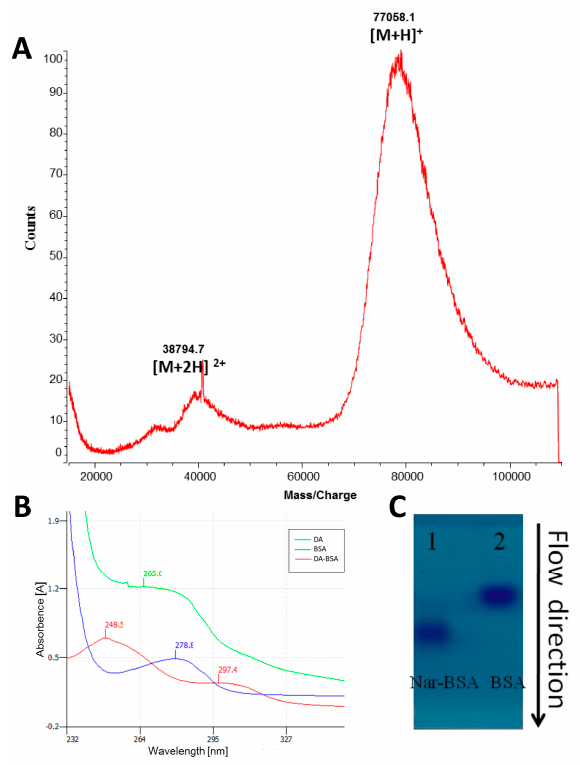
Figure 1. ( A ) Direct determination of the hapten number in the naringin-bovine serum albumin (Nar-BSA) conjugate by matrix-assisted laser desorption/ionization TOF mass spectrometry. [M + H] + and [M + 2H] 2+ are single- and double-protonated molecules of Nar-BSA, respectively [14]. Reprinted with permission from Huihua Qu et al. (2016), Copyright 2016 JSSC; ( B ) UV Spectrum of daidzin (DA), BSA, and DA-BSA [45]. Reprinted with permission from Huihua Qu et al. (2016), Copyright 2016 JSSC; ( C ) Analysis of Nar-BSA conjugate and carrier protein BSA via non-denaturing agarose electrophoresis. Lane 1: Nar-BSA conjugate, Lane 2: BSA [14].